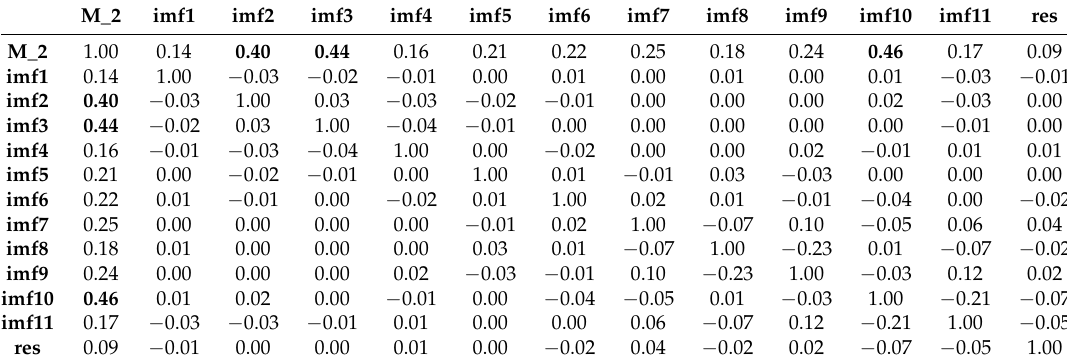
Table A2. M_2 load component correlation coefficient